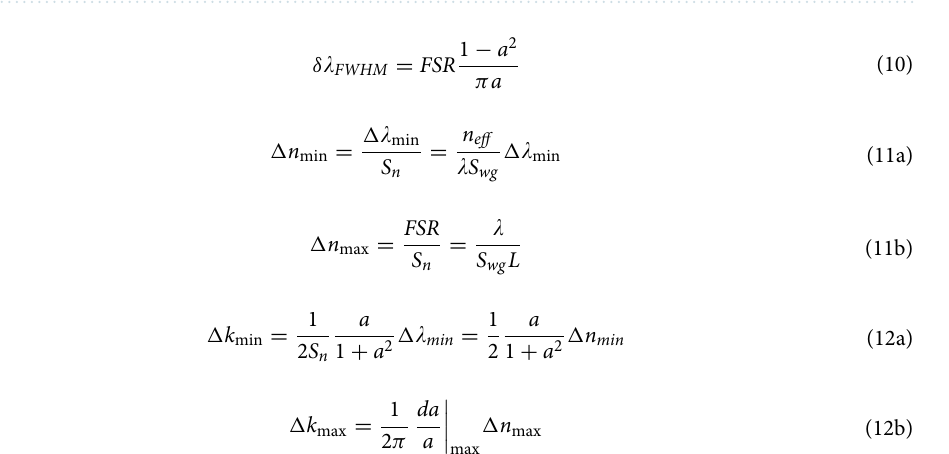
Figure 1. ( a ) S n "solid"and S k "dotted", ( b ) Δn min "solid" and Δn max "dotted", ( c ) Δk min "solid" and Δk max "dotted" versus cavity length at different S wg